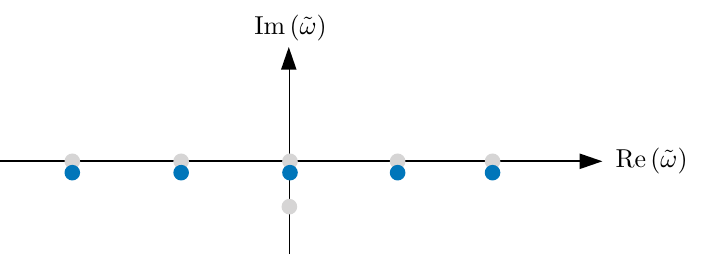
Figure 4 . Within a (cid:12)nite-sized system, the saddle points corresponding to di(cid:11)erent vorticities are displaced from the real line (blue dots). Although their real part is the same as in the in(cid:12)nite-sized case (grey dots along real axis), they also feature a small imaginary component. In particular, the saddle point corresponding to the k = 0 sector moves towards the position corresponding to unscreened charge (grey dot on imaginary